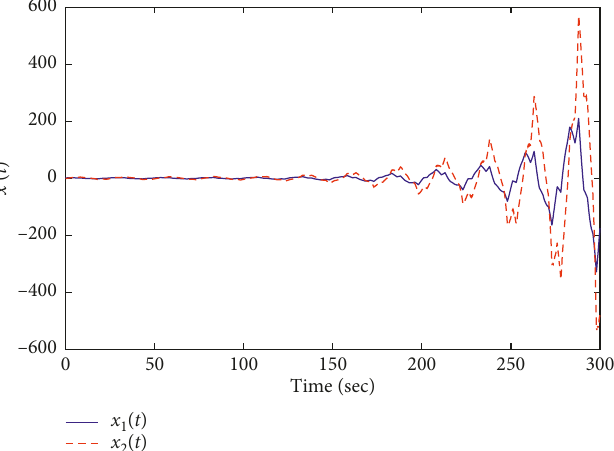
Figure 3: The system state responses under the controller solved by Corollary